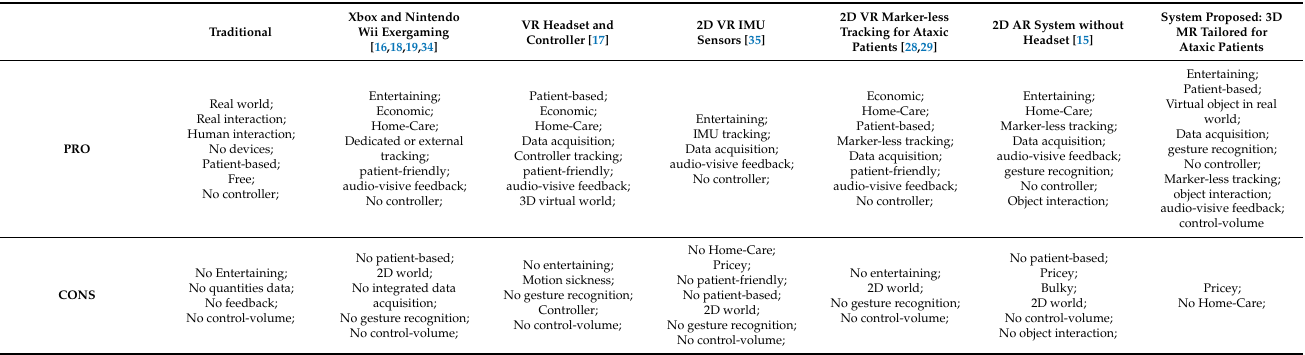
Table 2. Comparison of exergaming used for upper limb rehabilitation for ataxic